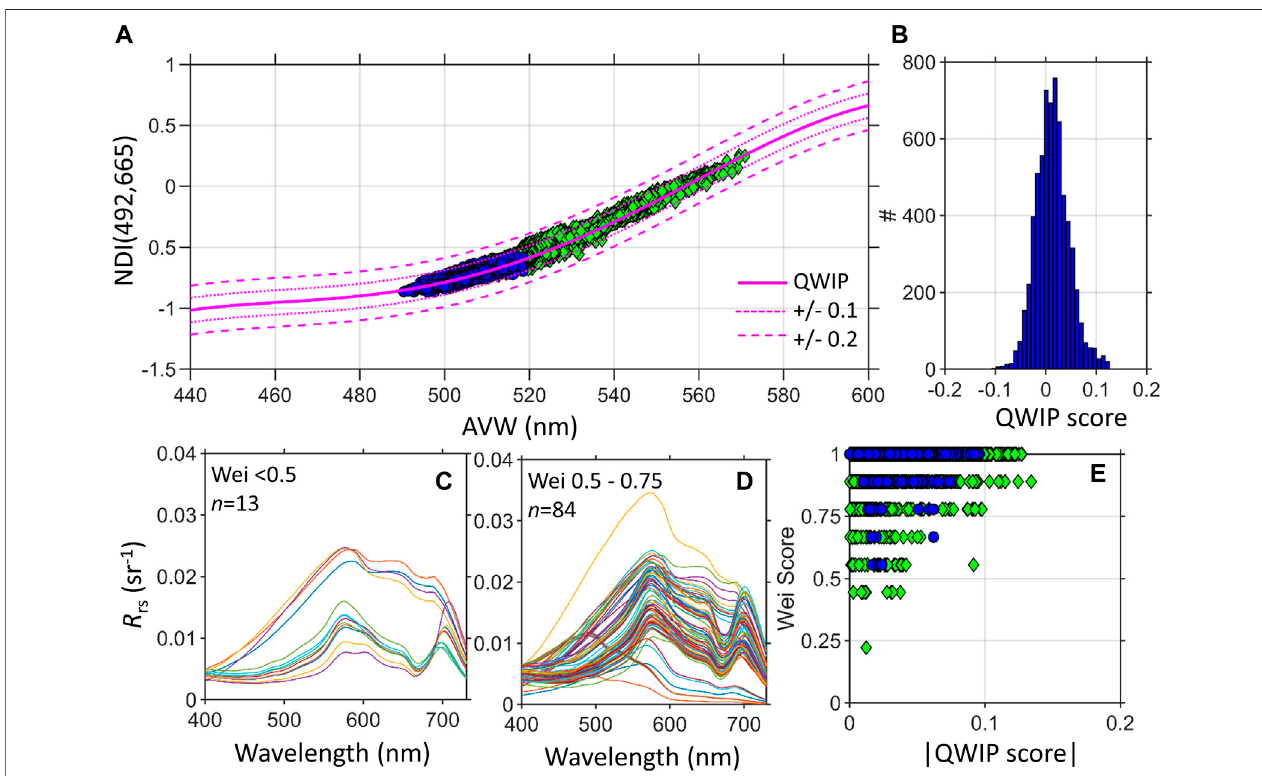
FIGURE 5 | (A) The QWIP scores from highly quality controlled hyperspectral PANTHYR re fl ectance data from Vanhellemont (2020). (B) QWIP scores were predominantly within < ± 0.1. Water types include: Blue-green (blue circles), Green (green diamonds) and Brown (red squares). Remote sensing re fl ectance of data with Wei scores (C) less than 0.5 (D) between 0.5 and 0.75. (E) Comparison of Wei scores (Wei et al., 2016) and the absolute value of QWIP scores for the entire